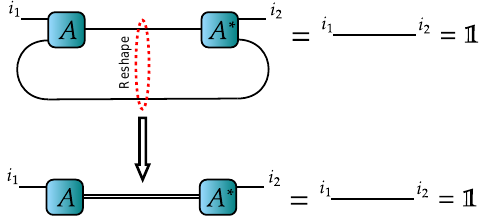
Figure 3: Diagrammatic representation of the reshape operation turning the tensor A into an isometric resh